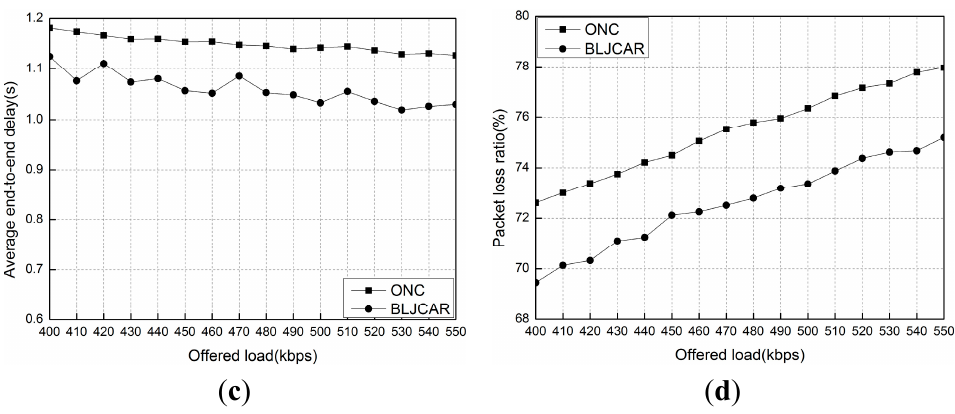
Figure 12. ( a) Average packet jitter versus offered load; ( b ) Network throughput versus offered load; ( c ) Average end-to-end delay versus offered load; ( d ) Packet loss ratio versus offered